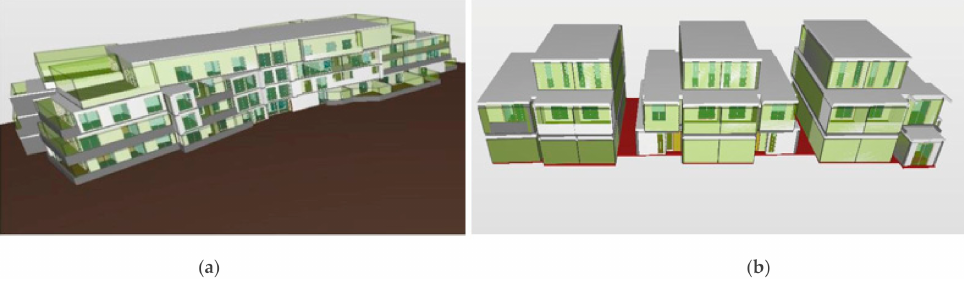
Figure 18. The Industry Foundation Class (IFC) model of the first real dataset in Solibri AnyWhere (light green solids show the legal spaces), ( a ) building 1, ( b ) building 2.